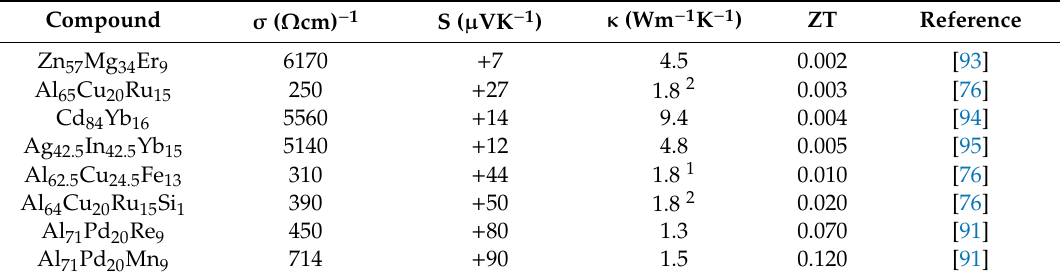
Table 5. Room temperature values of the electrical conductivity ( σ ), Seebeck (S), thermal conductivity ( κ ) transport coe ffi cients and figure of merit (ZT) for i-QCs belonging to di ff erent alloy